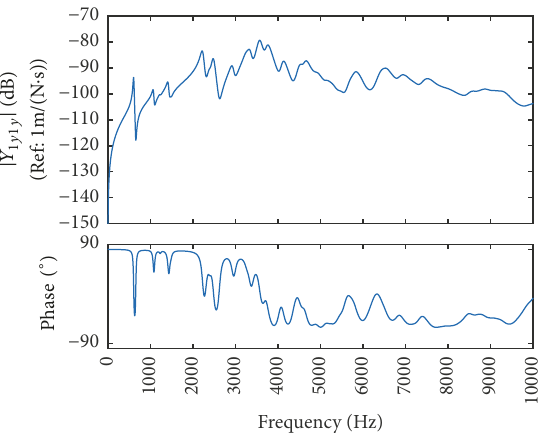
Figure 6: Driving point mobility at node 1 of the housing in the 𝑦